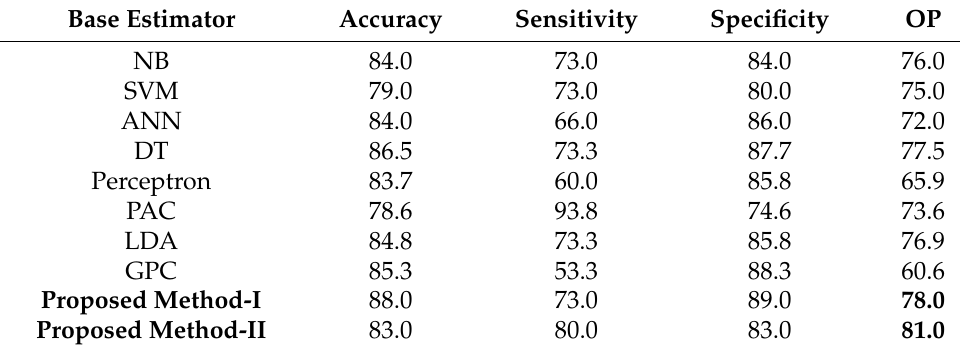
Table 4. Spectf Results with different base